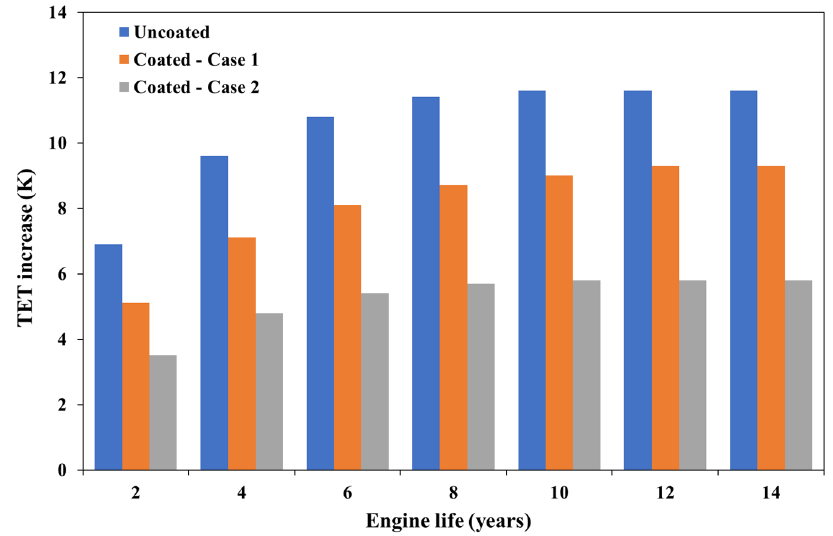
Figure 5. TET variation with time for uncoated and two LPC-coated scenarios.